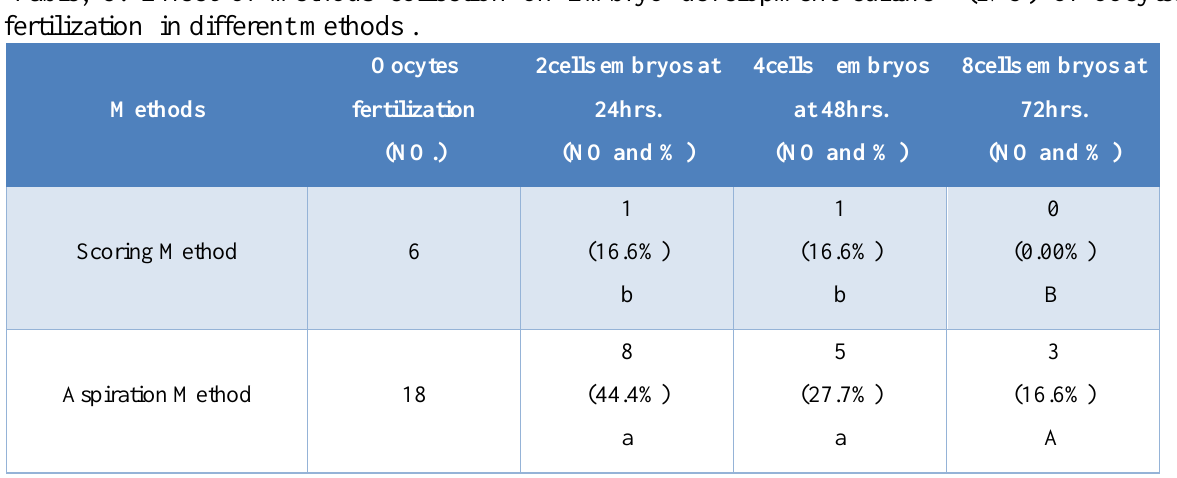
*Different small letters vertically denote significant (P<0.05) between collection methods of embryo development